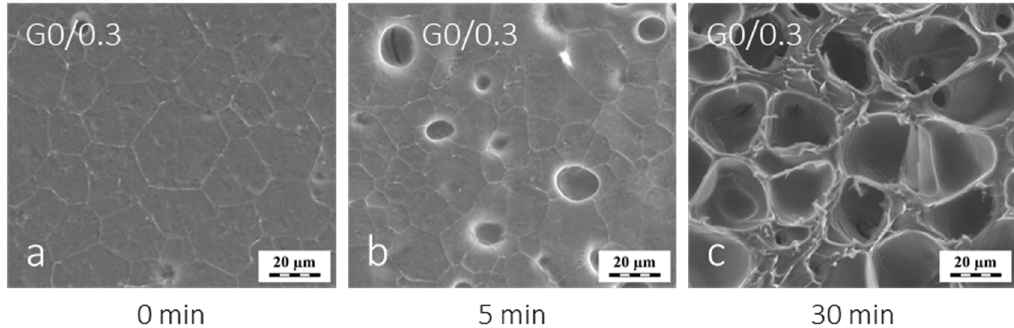
Figure 3. E ff ect of the time of exposition to electrons in the microscope chamber in cryo-SEM experiment on development of secondary pores in plunge-frozen water-swollen G0 / 0.3 hydrogel. ( a ) Initial specimen covered with a layer of frozen water (t ~ 0 min), ( b ) sublimation of ice in progress (t ≈ 5 min) and ( c ) complete sublimation of ice from the surface of the scanned area (t ≈ 30